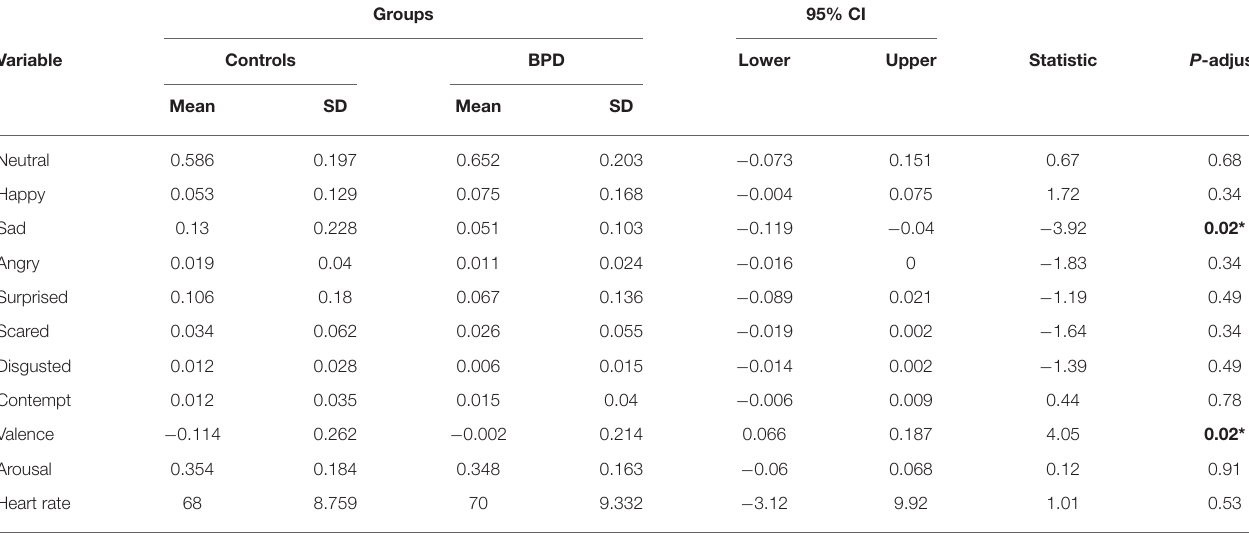
TABLE 1 | Facial expression of emotion frequency.